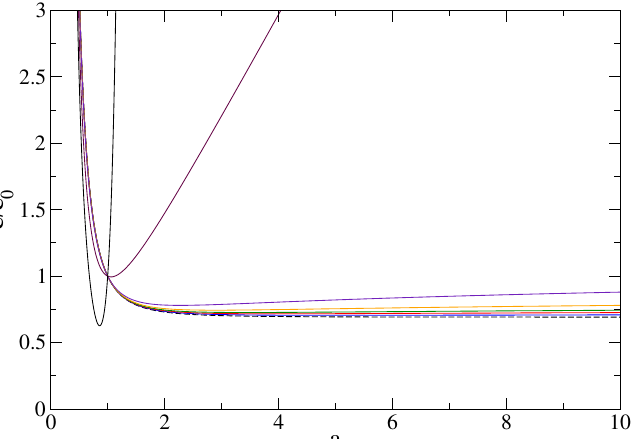
Figure 1. Normalized energy density (cid:101) / (cid:101) 0 as a function of the scale factor a for Ω m ,0 = 0.309, B = 3.53 × 10 − 3 and various values of n : n = 0 (dashed black, Λ CDM model), n = 1 (blue, original logotropic model), n = 2 (red), n = 3 (green), n = 5 (orange), n = 10 (indigo), n = 100 (maroon), n = 1000